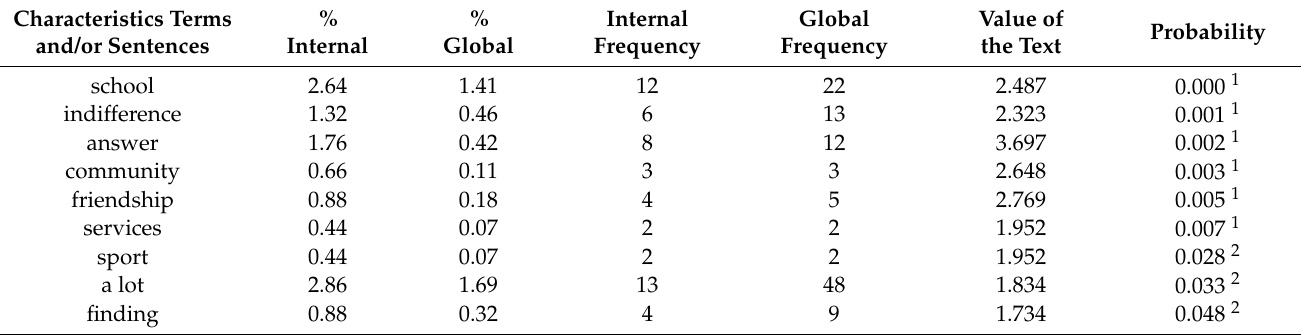
Table 3. Parents’ answers to the question “What are, in your opinion, the causes of school